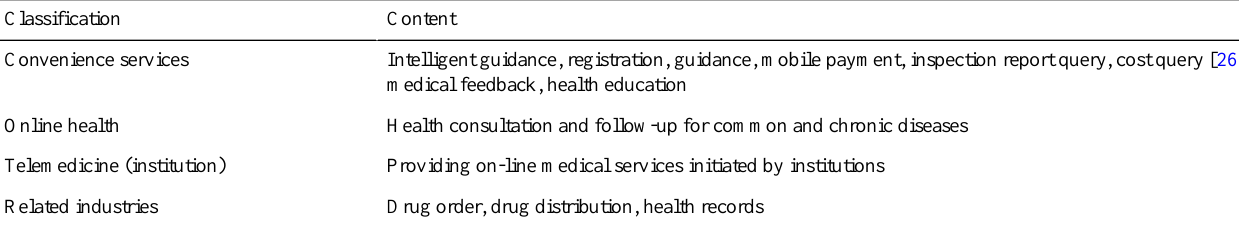
Table 2. Internet hospital service classification.